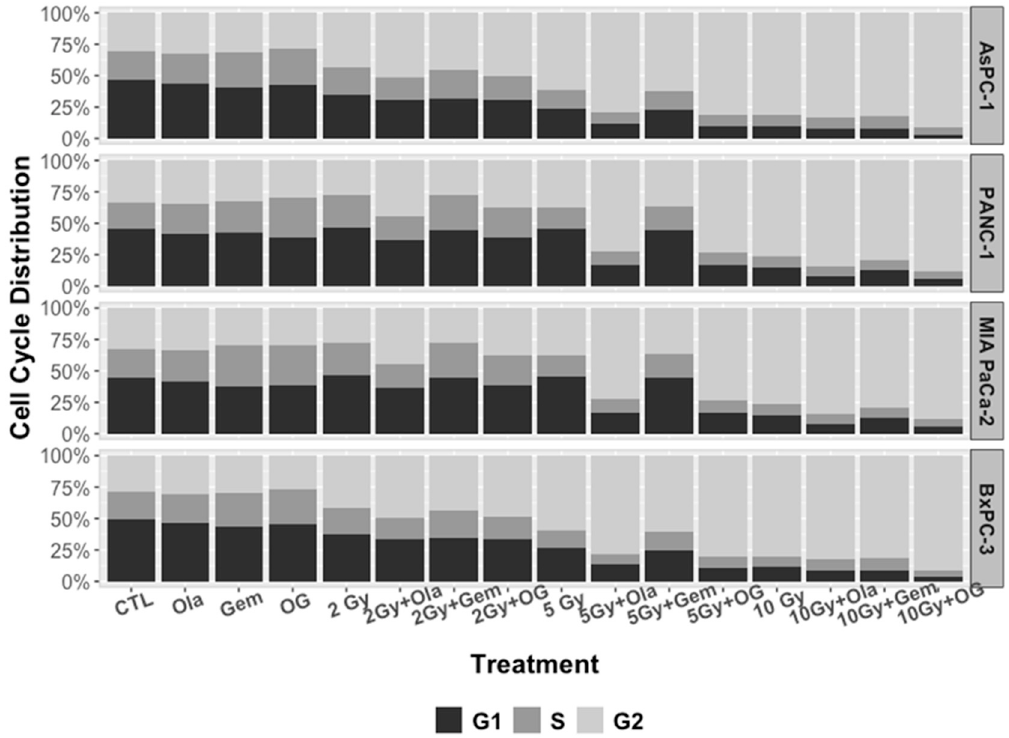
Figure 5. Cell cycle distribution of AsPC-1, PANC-1, MIA PaCa-2 and BxPC-3 cell lines, after irradiation (2, 5 and 10 Gy) and treatment with olaparib (1 µM) and/or gemcitabine (10 nM). Table 3. Percentages of cell in S phase after control (CTL) and gemcitabine (10 nM) for AsPC-1,